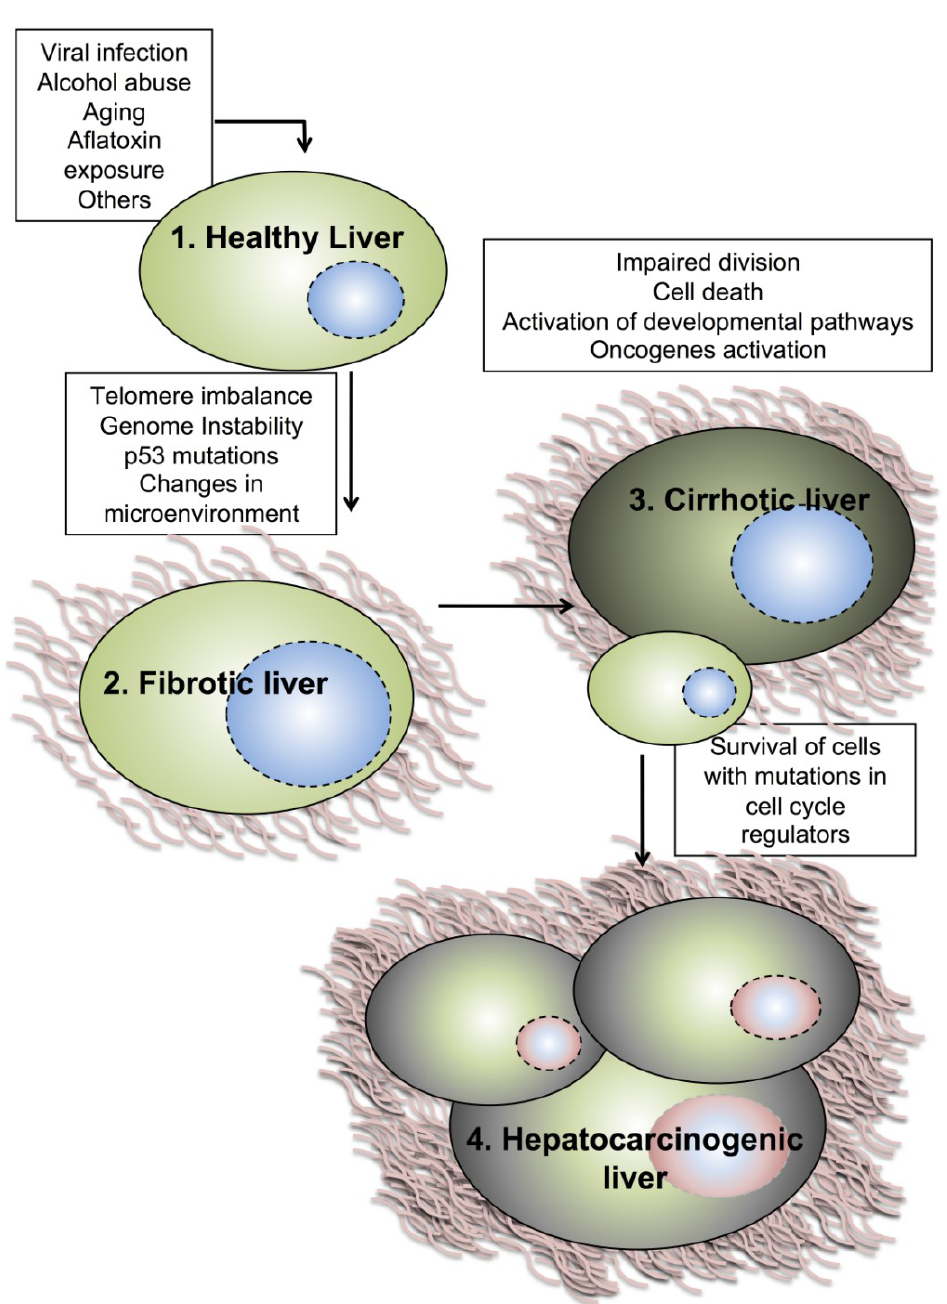
Figure 1. Model for the development of primary liver tumors. Several risk and etiologic factors can lead to development of primary tumors in the liver. HCV and HBV infection, heavy alcohol intake, exposure to aflatoxin, drugs, and others can lead to cycles of damage-cell death-regeneration in the liver. This, together with genome instability and changes in the microenvironment, can create a scenario where hepatocytes start to activate oncogenic and developmental pathways. Only those hepatocytes with mutations in cell cycle regulators will survive and divide, resulting in malignancy and